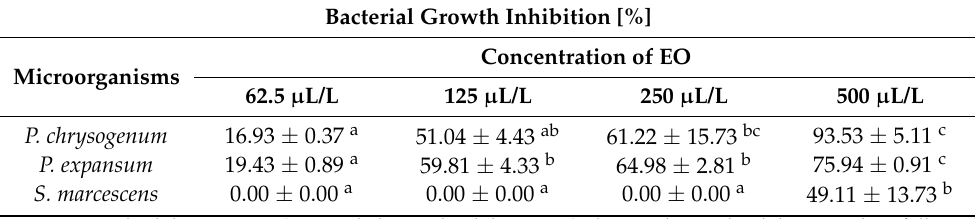
Table 4. Results of in situ analysis of antimicrobial activity of the vapor phase of CEO on carrots. Bacterial Growth Inhibition